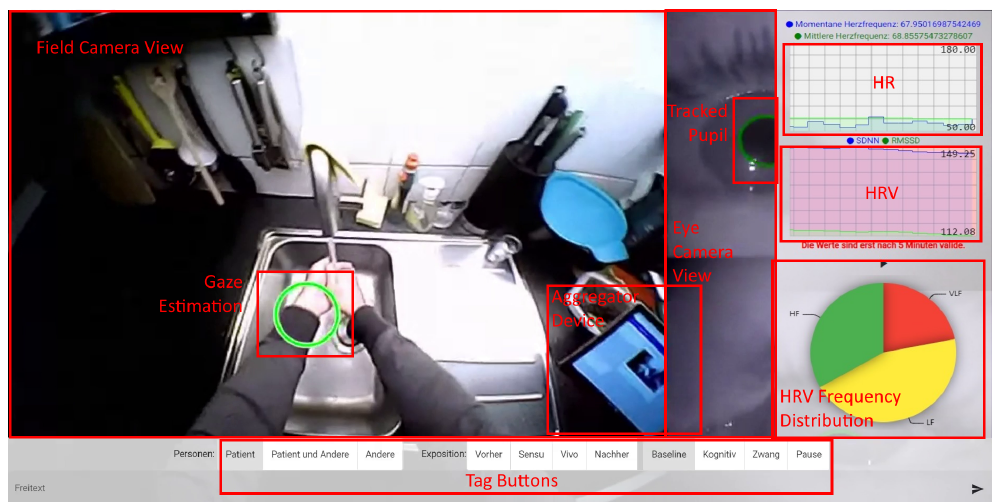
Figure 16. Therapist Portal with sensor data streaming in action. Green labels are displayed to therapist, rectangular red labels are inserted to mark concepts described in the